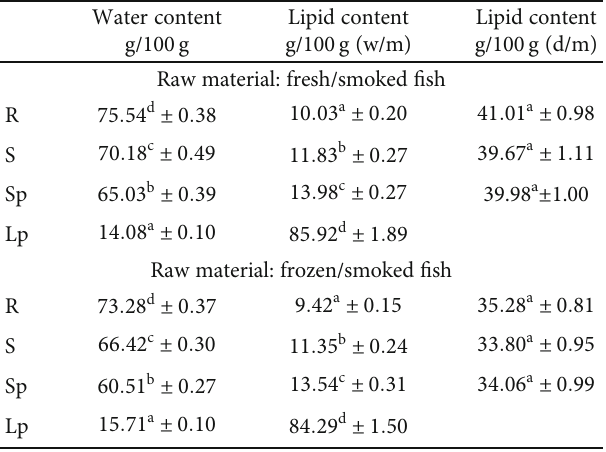
Table 2: Water and lipid content in raw fi sh, smoked fi sh, and solid and liquid parts of canned fi